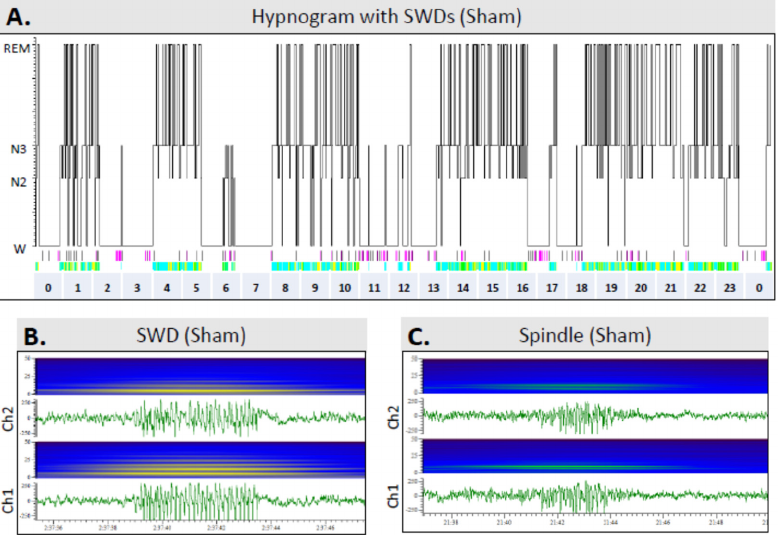
Figure 9. Occurrence of spike-and-wave discharges (SWDs) over the 24-hour sleep–awake cycle: ( A ) A hypnogram in a sham-operated experimental control rat (#39). ( B ) An SWD and associated power spectrum in a sham-operated rat (#39). SWDs are indicated by light-green bars below the hypnogram (panel ( A )). Note their occurrence only during awake periods. Moreover, note the harmonics in the power spectrum. ( C ) An N3 sleep spindle in a sham-operated rat (#39), and corresponding power spectrum. Occurrence of sleep spindles is indicated by purple bars below the hypnogram in panel ( A ). Note the single frequency band in the power spectrum. Abbreviations: Ch, electroencephalogram recording channel (see Figure 3B); N2, N2 sleep stage; N3, N3 sleep stage; REM, rapid eye movement sleep; W, awake.